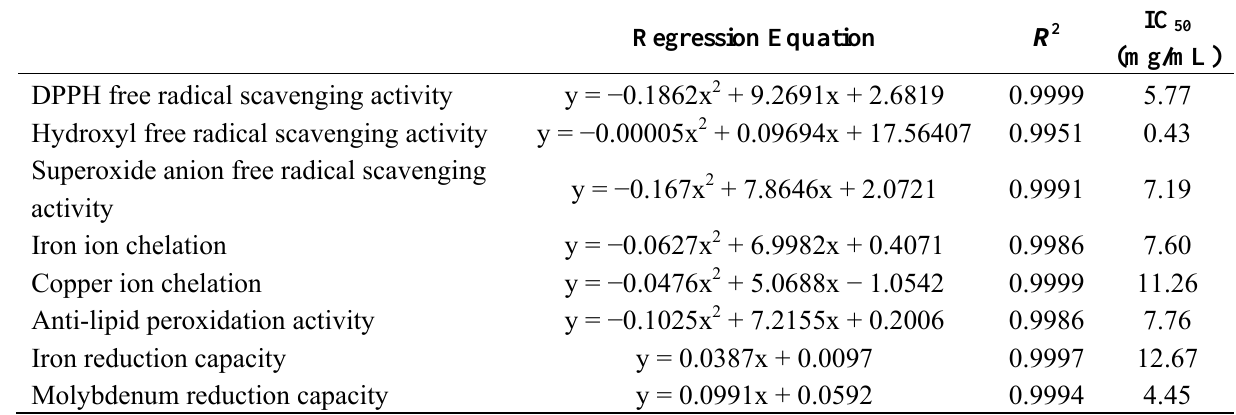
Table 4. Results of antioxidant